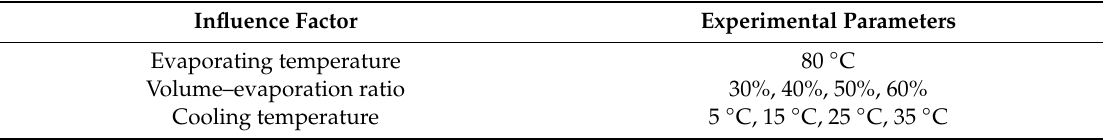
Table 4. Experimental scheme for RHF secondary dust alkali leaching liquid